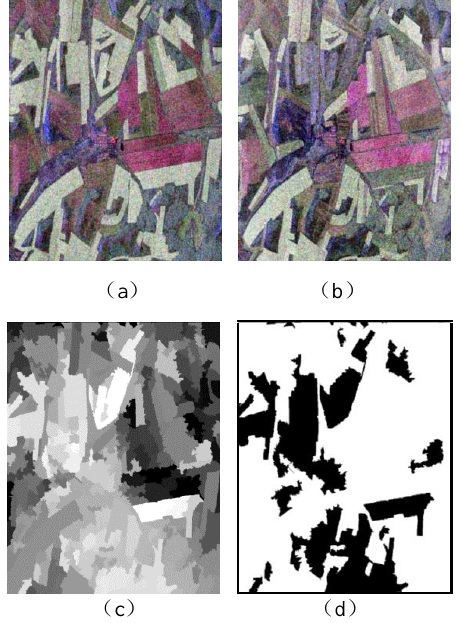
Figure 5. The change detection results based on the difference of polarimetric scattering, (a) image 1, (b) image 2, (c) difference map, (d) the results of change detection Fifty patches are chosen as samples random to evaluate the accuracy of the change detection results. In the extracted 50 samples, combined with the results of field location-survey,